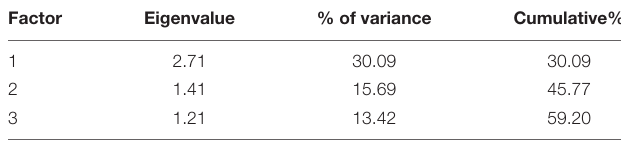
TABLE 7 | Results of the factor analysis for the body parts of the PRP ( n = 549). Items Upper limbs Upper body Third factor